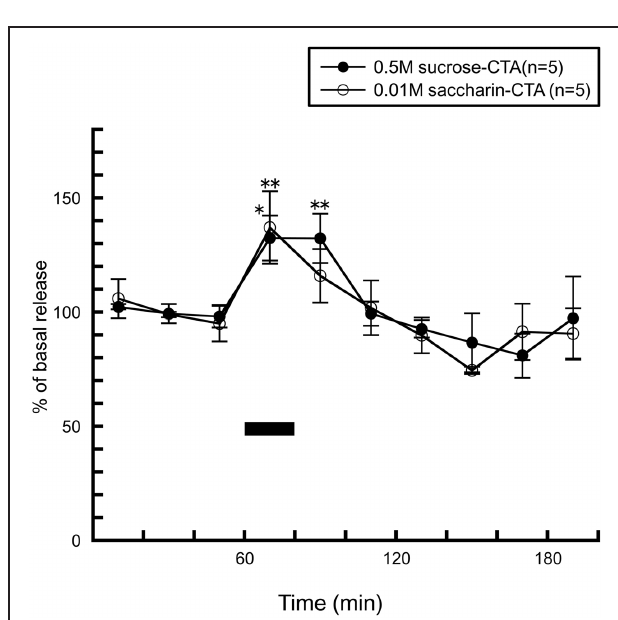
of taste solution infusion. The mean values of the three baseline samples preceding intraoral infusion were taken as 100%. Values are presented as percentages of the mean basal release ± SEM ∗∗ p < 0 . 01, ∗ p < 0 . 05 compared with the basal release of each group, respectively.